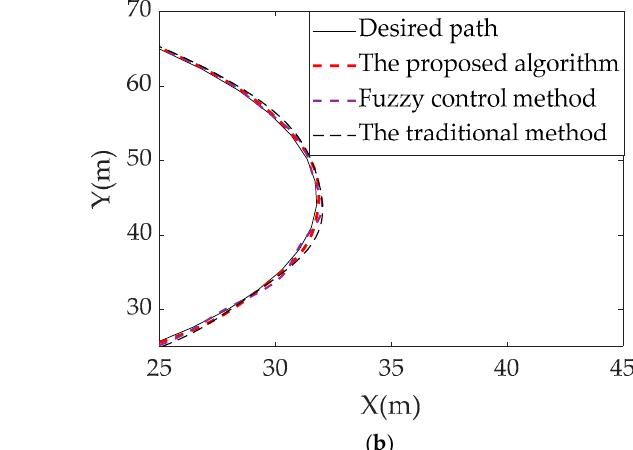
Figure 18. Cross-track position error for the Archimedean spiral. Figure 19. Cross-track heading angle error for the Archimedean spiral. Table 2. Comparison of the proposed and existing algorithms. Method